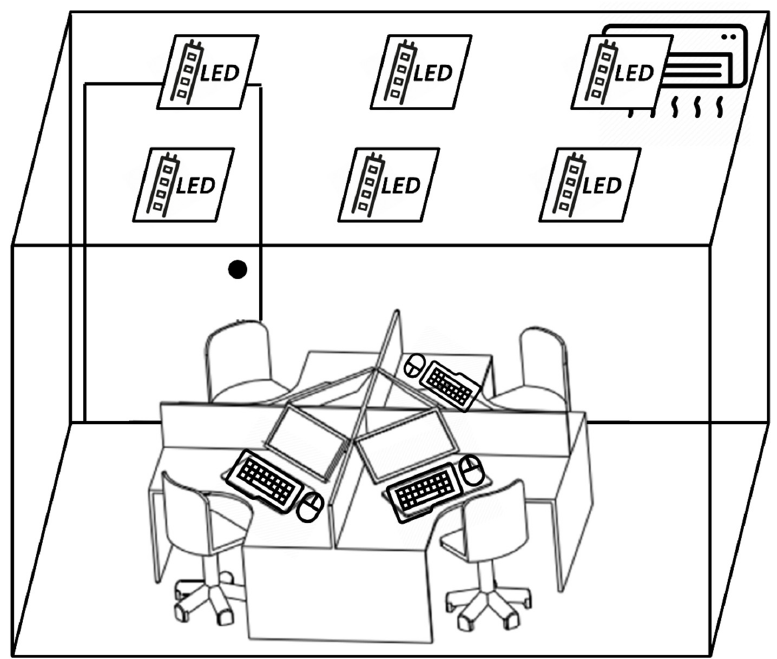
Figure 1. The layout of the laboratory. Note that only one participant was scheduled at a time.